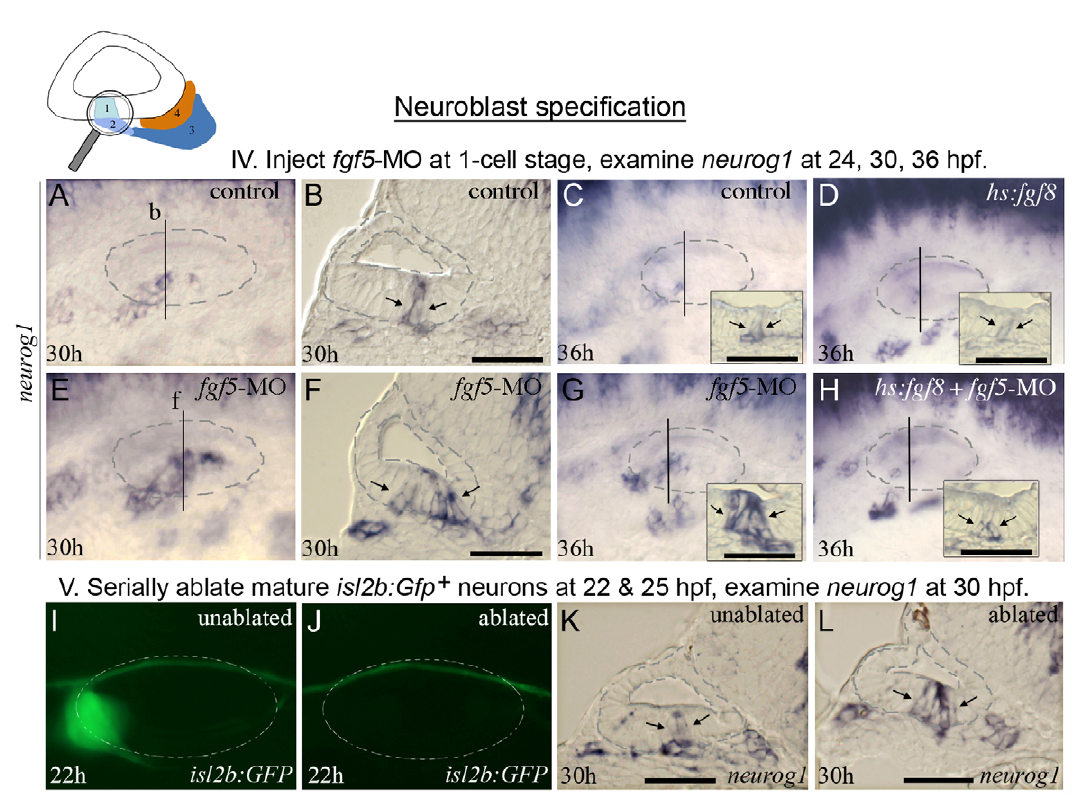
Figure 6. fgf5 from mature neurons terminates the phase of neuroblast specification. The icon at the top of the figure indicates that analysis focuses on initial formation of neuroblasts. Experimental manipulations in groups IV and V are briefly summarized at the tops of the corresponding data panels. (A–H) Expression of neurog1 in control embryos (A–C), a hs:fgf8 embryo (D), fgf5 morphants (E–G), and a hs: fgf8 embryo injected with fgf5 -MO (H) at the indicated stages. Transgenic embryos (D, H) were heat shocked for 30 minutes at 39 u C beginning at 24 hpf. Vertical lines in (A, C–E, G, H) indicate the plane of transverse sections in (B, F, and insets in C, D, G and H). (I–L) Expression of isl2b:Gfp at 22 hpf (I, J) and neurog1 at 30 hpf (K, L) in a specimen in which mature ( fgf5 -expressing) neurons were laser-ablated. The same specimen is shown in all panels. Mature SAG neurons expressing isl2b:Gfp were serially ablated on the left side at 22 hpf (J) and 25 hpf (not shown), and the embryo was fixed and sectioned at 30 hpf to examine neurog1 expression (L). Images of the unablated right side (I, K) were inverted to facilitate comparison. The surface of the otic vesicle is outlined in all panels. Arrows in sections indicate the edges of neurog1 domain in the otic floor. Note that the amount and duration of delamination of neurog1 + neuroblasts is strongly enhanced by knockdown of fgf5 (F, G) or ablation of mature neurons (L). Activation of hs:fgf8 reverses the effects of fgf5- MO (H). Scale bar, 25 m m. Transverse sections are shown with lateral to the left and dorsal up. Wholemount images show dorsolateral views with anterior to the left.